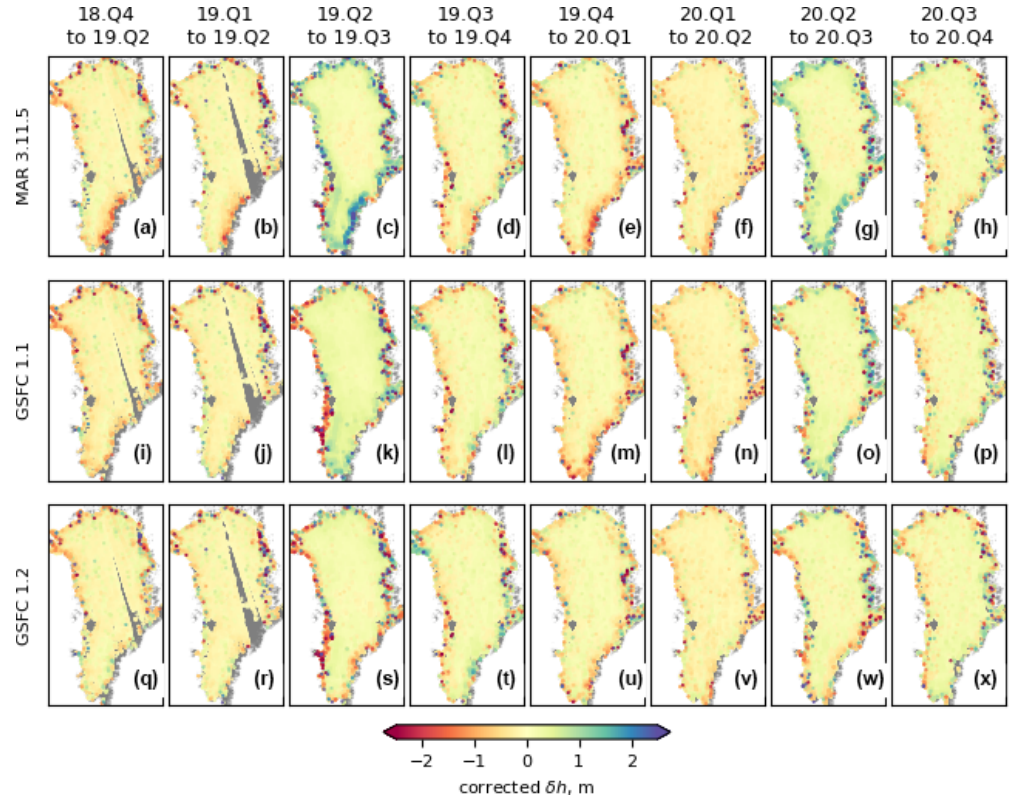
Figure 4. Residuals between measured and predicted height changes from MAR3.11.5 (a–h) , GSFCv1.1 (i–p) , and GSFCv1.2 (q–x) . Mea- surements are masked to remove areas where there have been large velocity